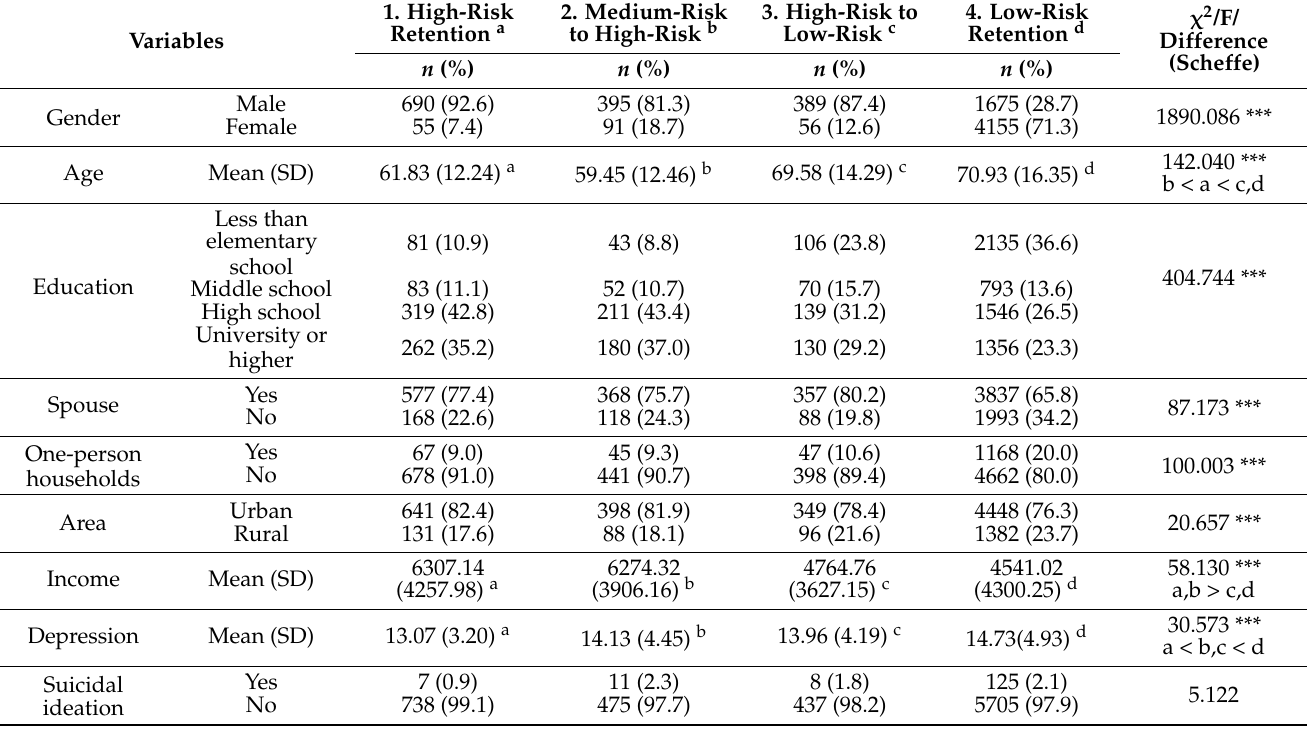
Table 4. Differences in demographics according to type of change in AUDIT scores variables.